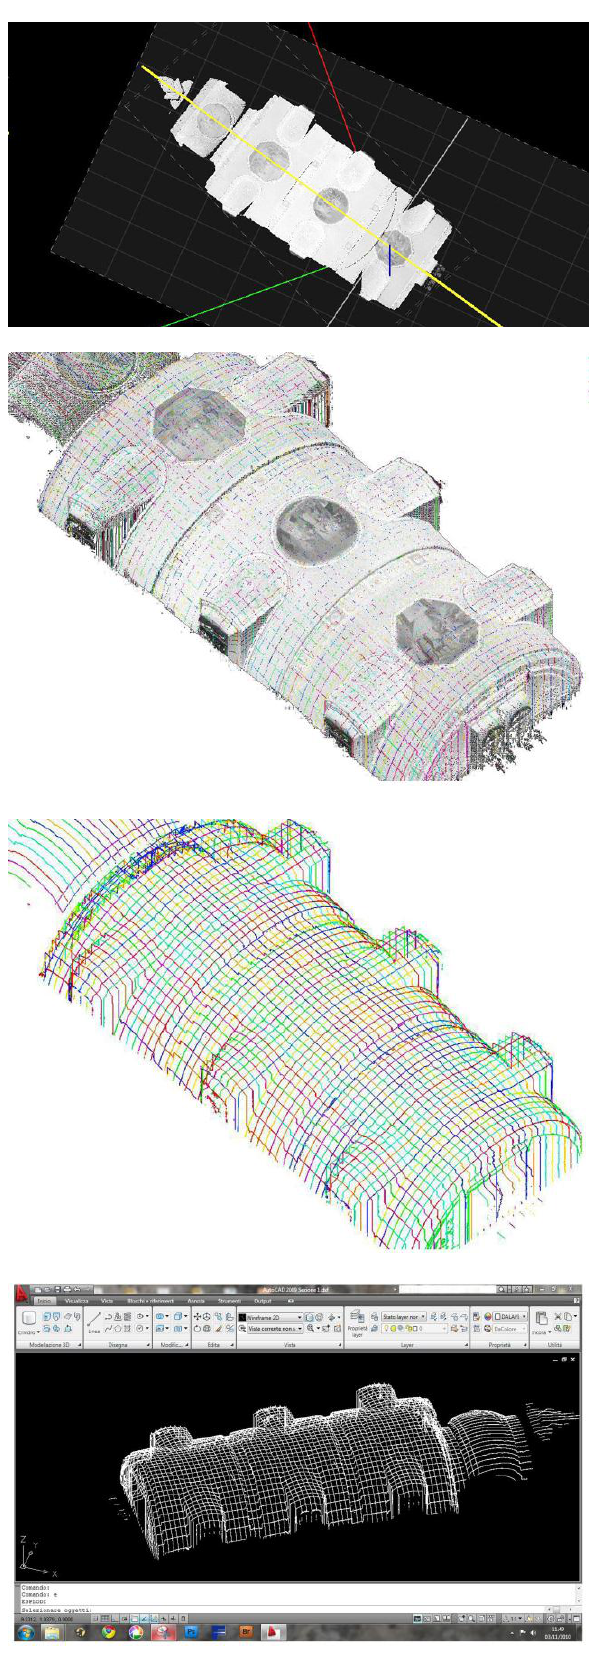
Figure 17. From point clouds to CAD